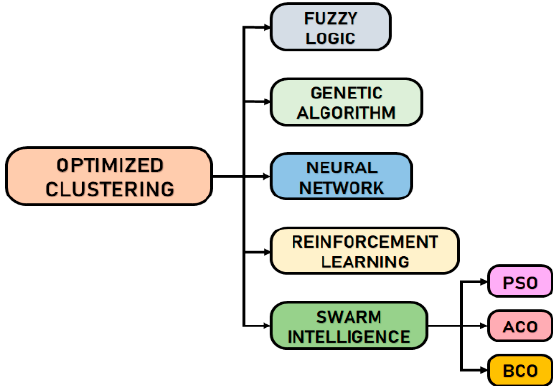
Figure 2. Classification of optimized clustering algorithms according to the Computational Intelligence (CI).